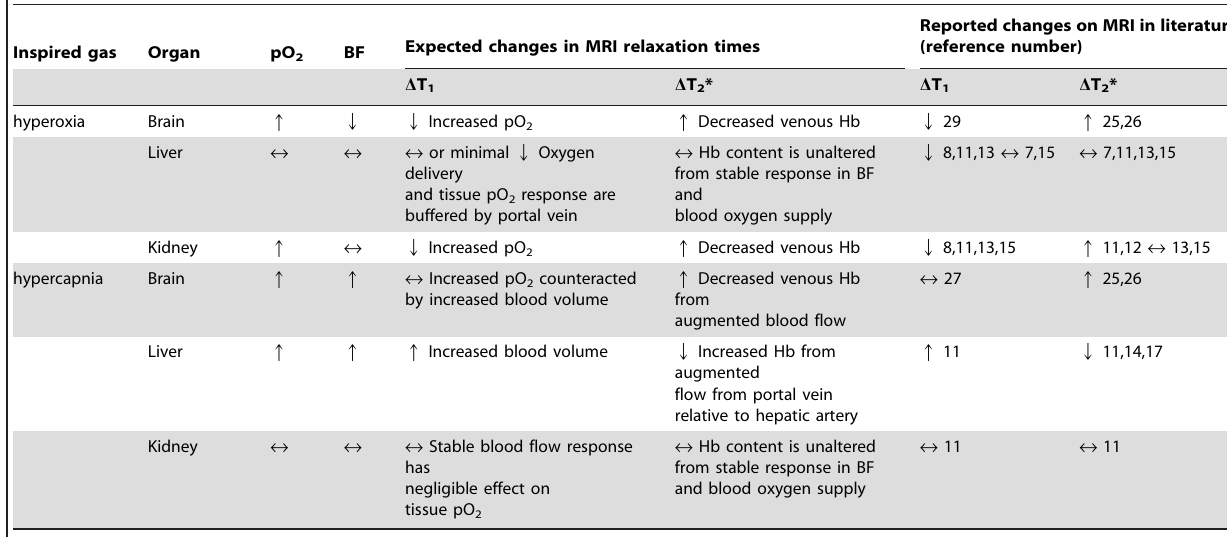
Table 3. Physiological changes observed and MRI response to hyperoxia and